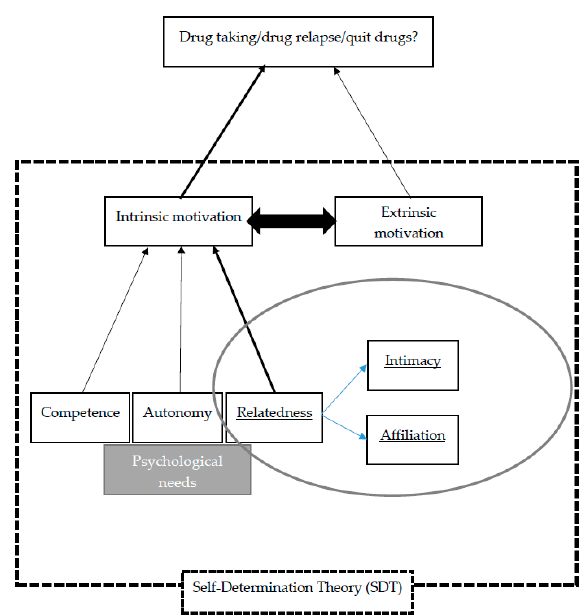
Figure 1. Theoretical framework for thematic analyses.